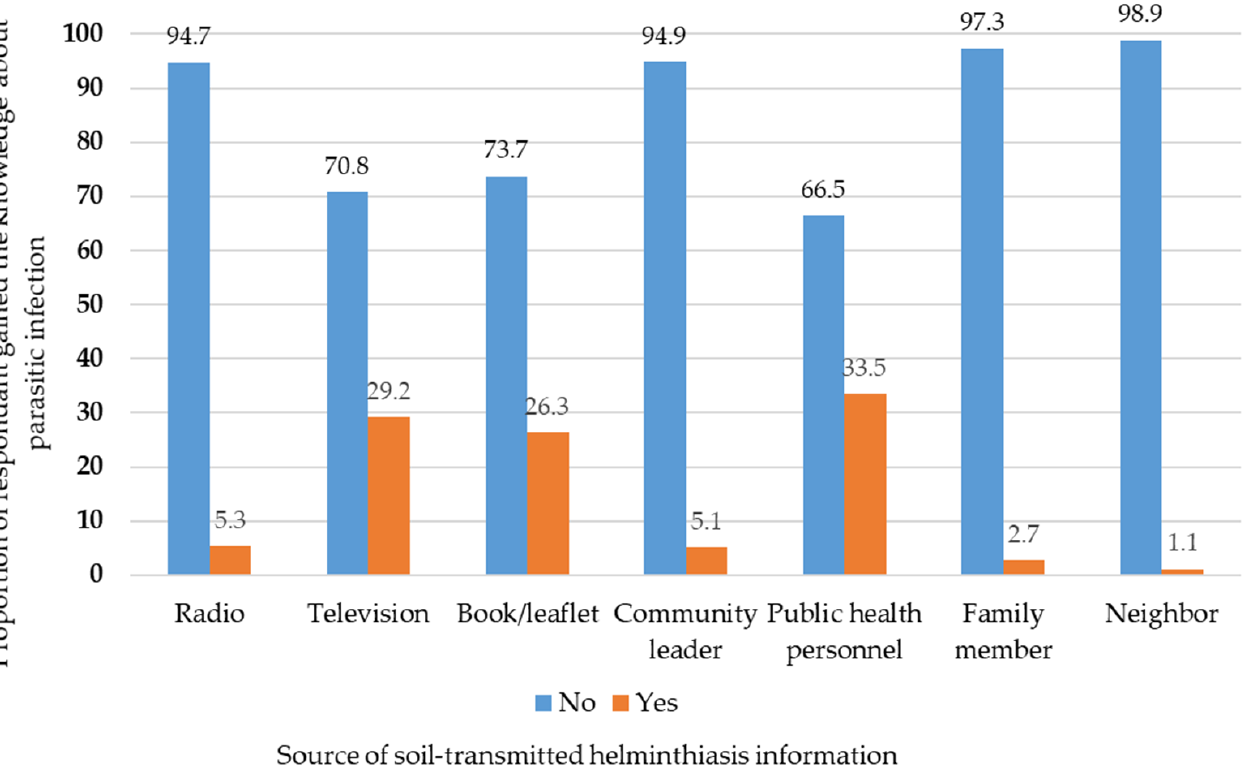
Figure 2. Proportion of respondents who gained knowledge on soil-transmitted helminthiasis by source.